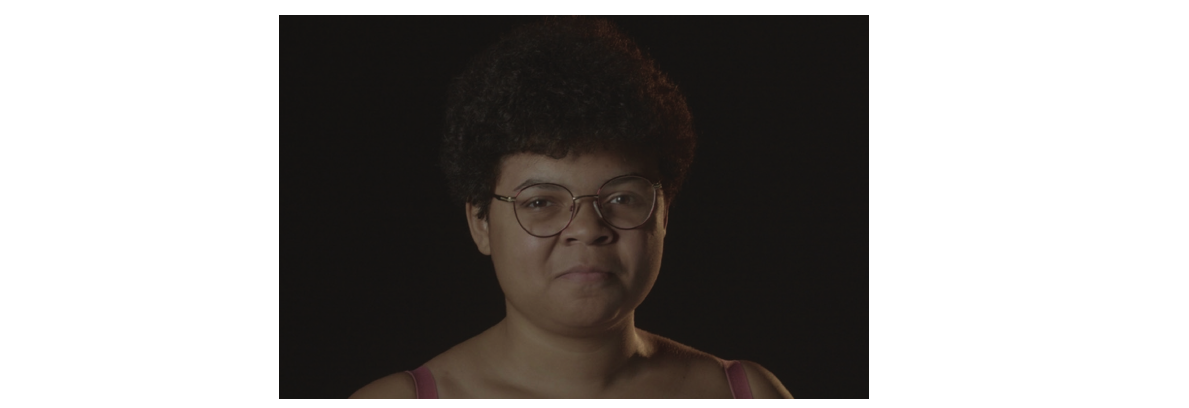
Figure 13. Close-up shot with cheerful mood by Group 3 (Source: Author,